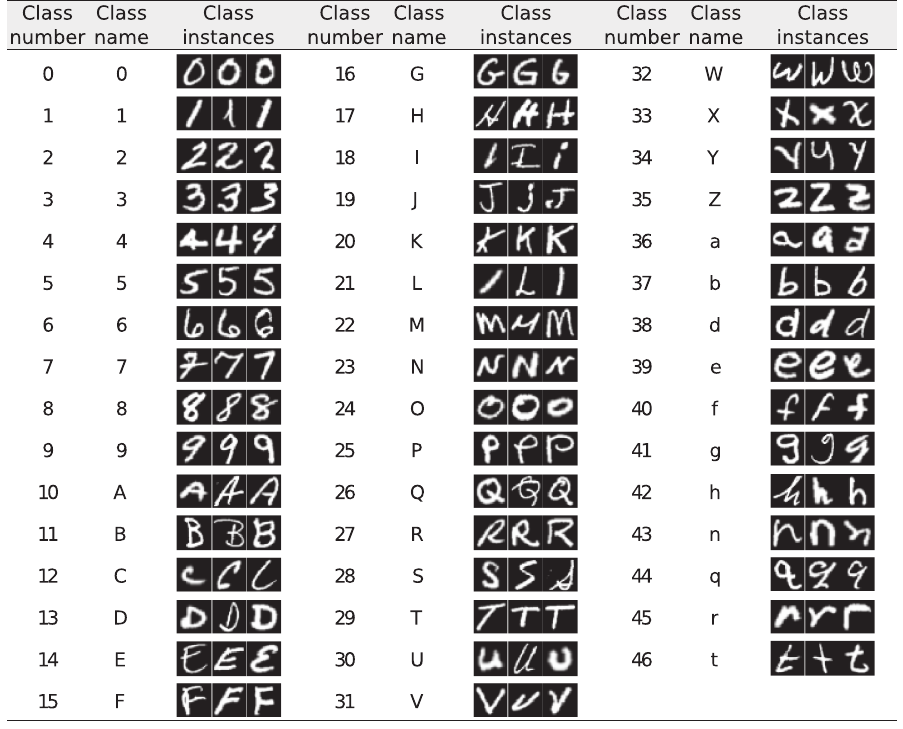
Fig 5. EMNIST-47